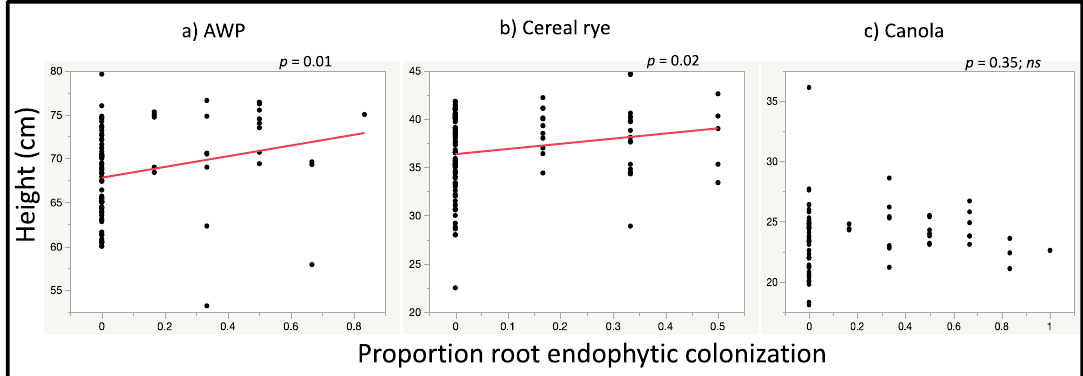
Figure 4. Relationship between the relative proportions of endophytic colonization of root tissue sections from which M. robertsii was recovered and height of ( a ) AWP, ( b ) cereal rye and ( c ) canola. No M. robertsii was recovered from non-inoculated control leaf and root tissue sections (data not shown). Regression lines for significant relationships between endophytic colonization and plant height are shown in red.